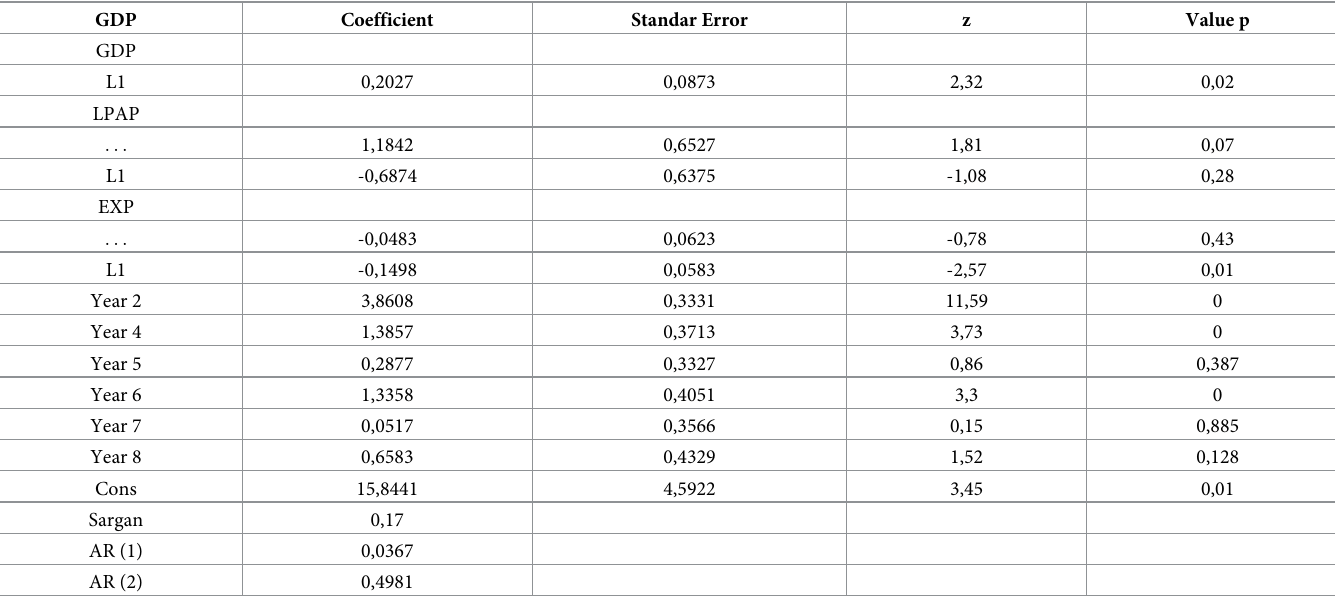
Table 1. Results of the GMM